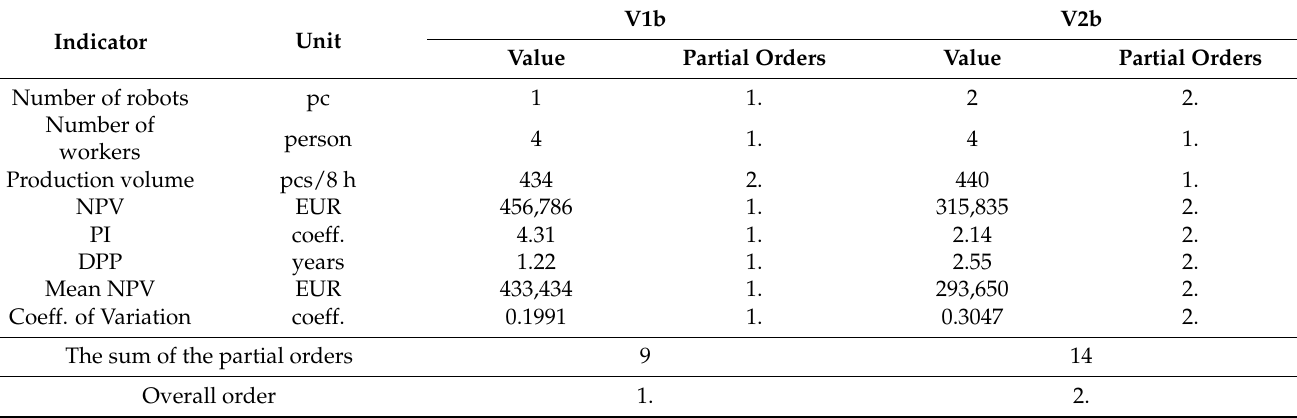
Table 10. Selection of the optimal version of the investment variant by the method of partial